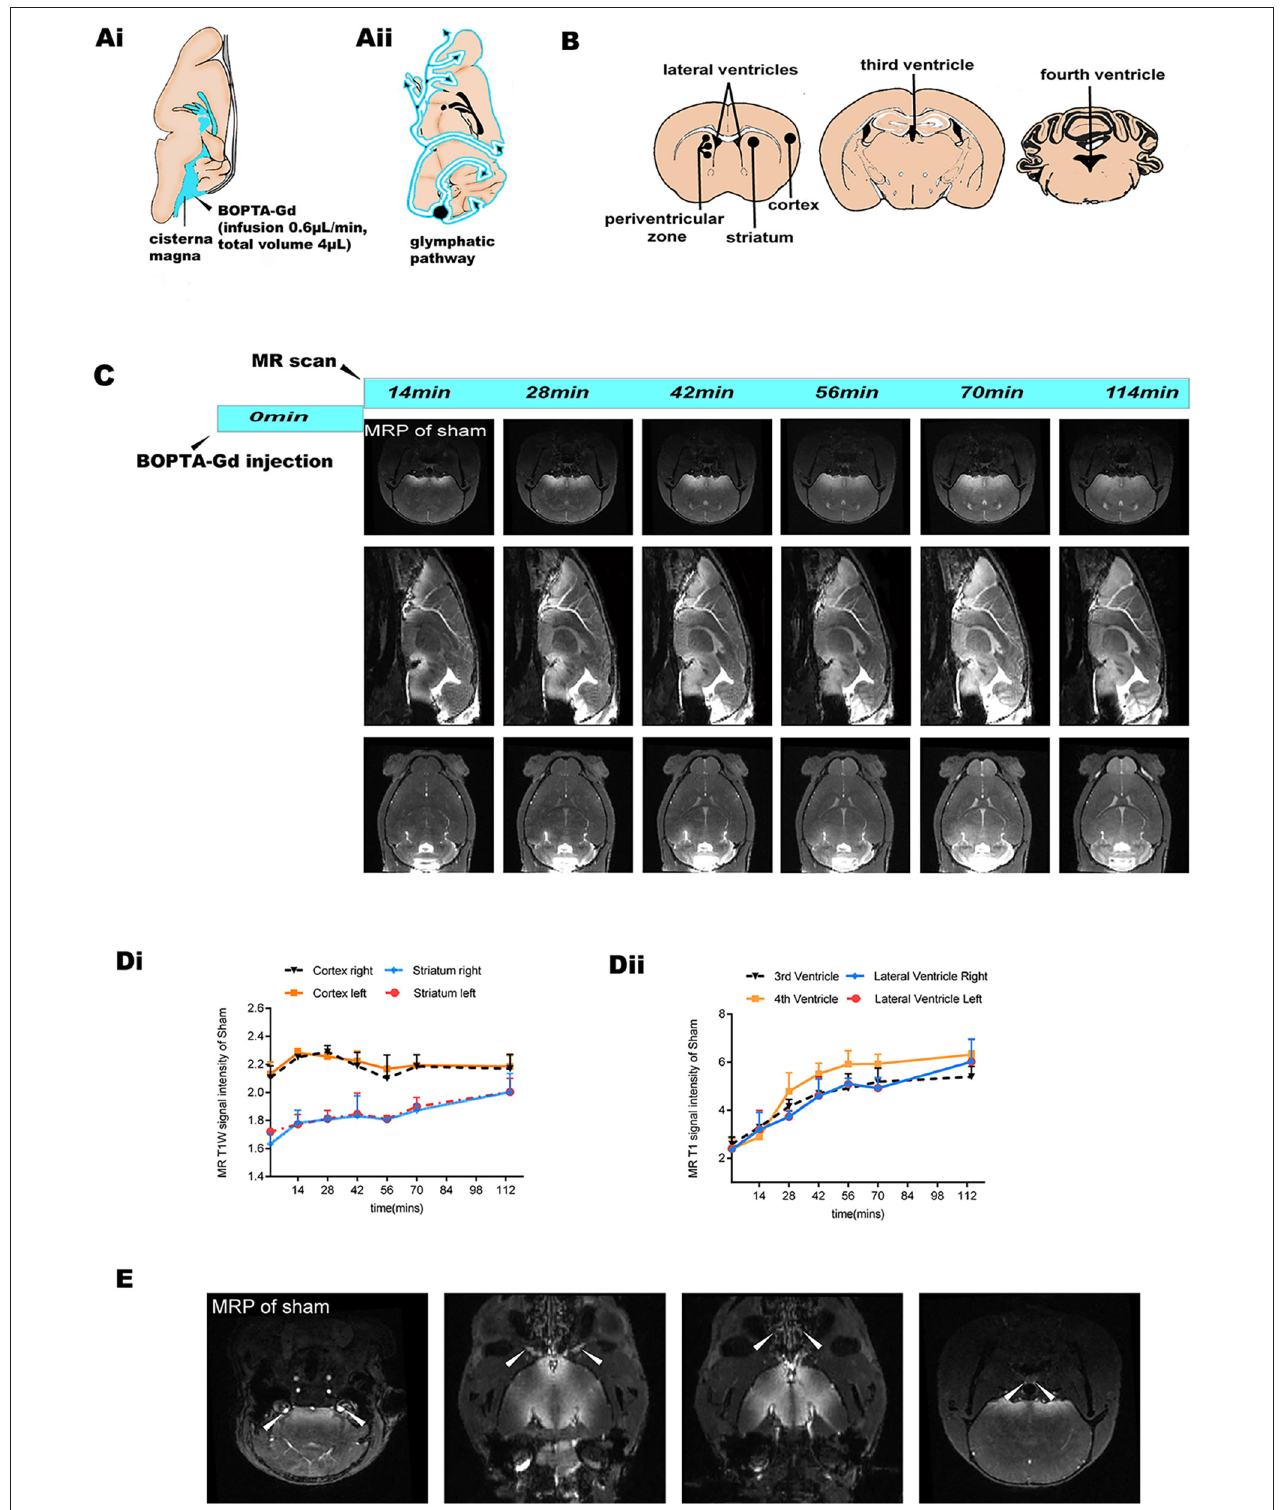
FIGURE 2 | MRI-based evaluation of glymphatic perfusion. (Ai,ii) Schematic diagram of cisterna magna injection and the CSF drainage routes from the cisterna magna (alongside cerebral ventricles and ventral brain surface). (B) Schematic diagram of the approximate ROIs used for MRI quantification of SI, including the striatum, cortex, periventricular zone, and bilateral, third, and fourth cerebral ventricles. (C) Representative coronal, sagittal, and axial slices of CEMRI MRP images